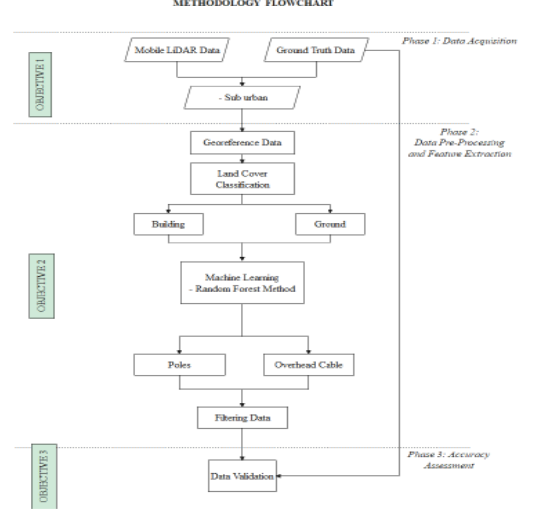
Figure 1 . Workflow of the research methodology